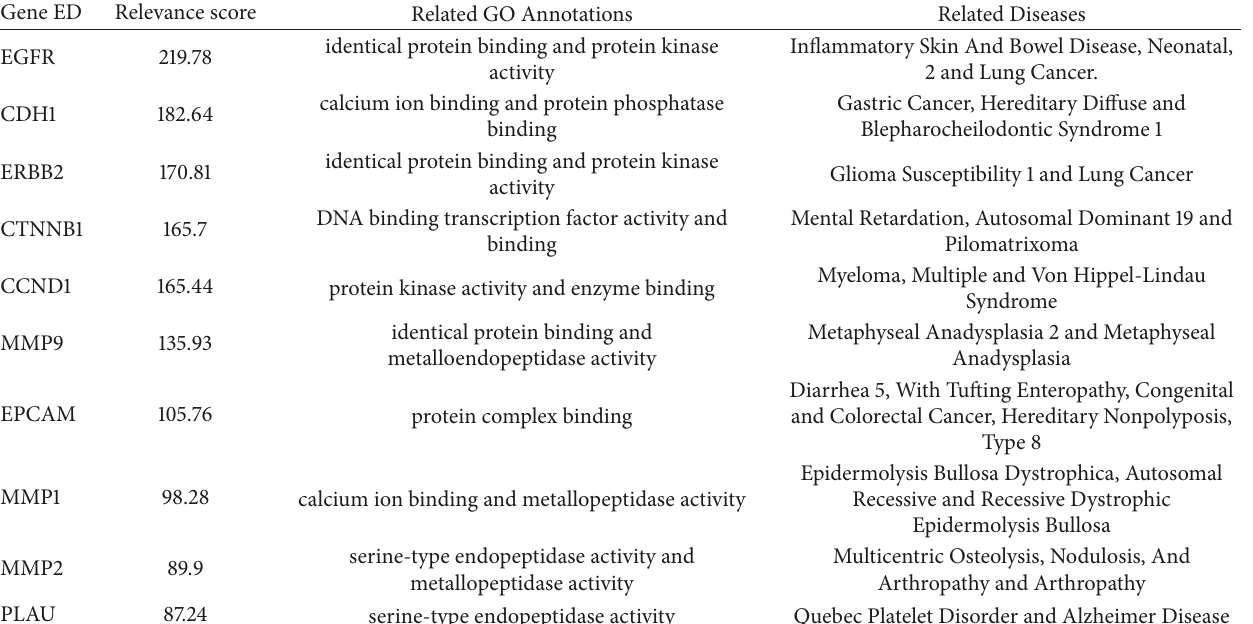
Table 5: The top ten genes in the COAD HNSC ESCA dataset by TRPCA.